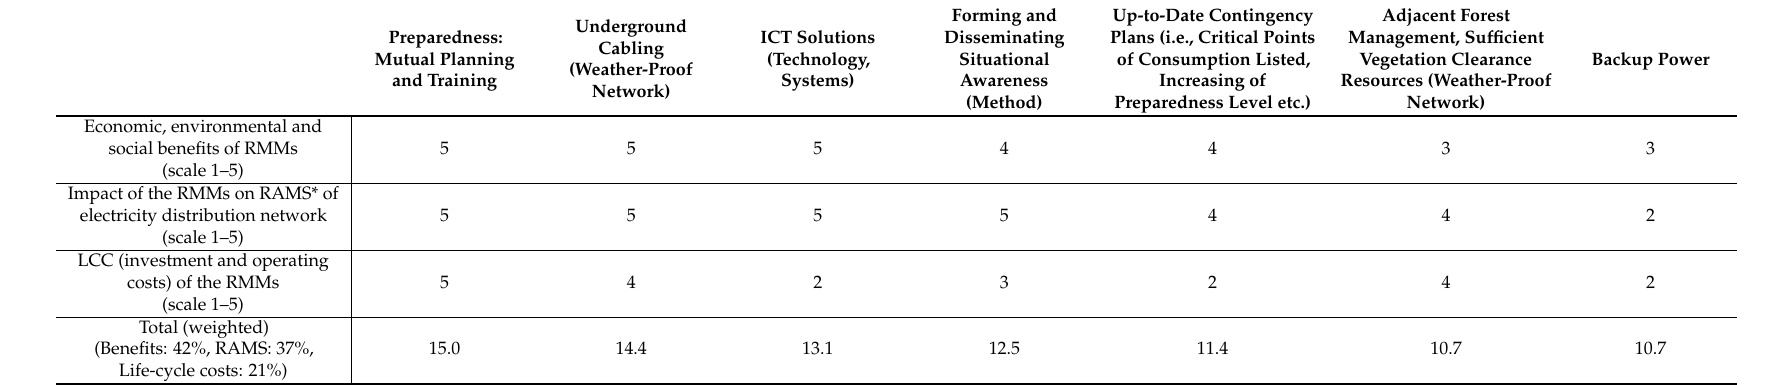
Table 3. Results of the assessment of the risk mitigation measures identified in the expert